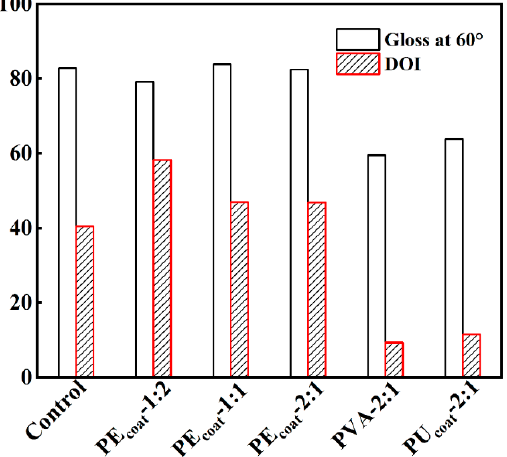
Figure 9. Gloss and DOI results of fluorescent powder coatings.